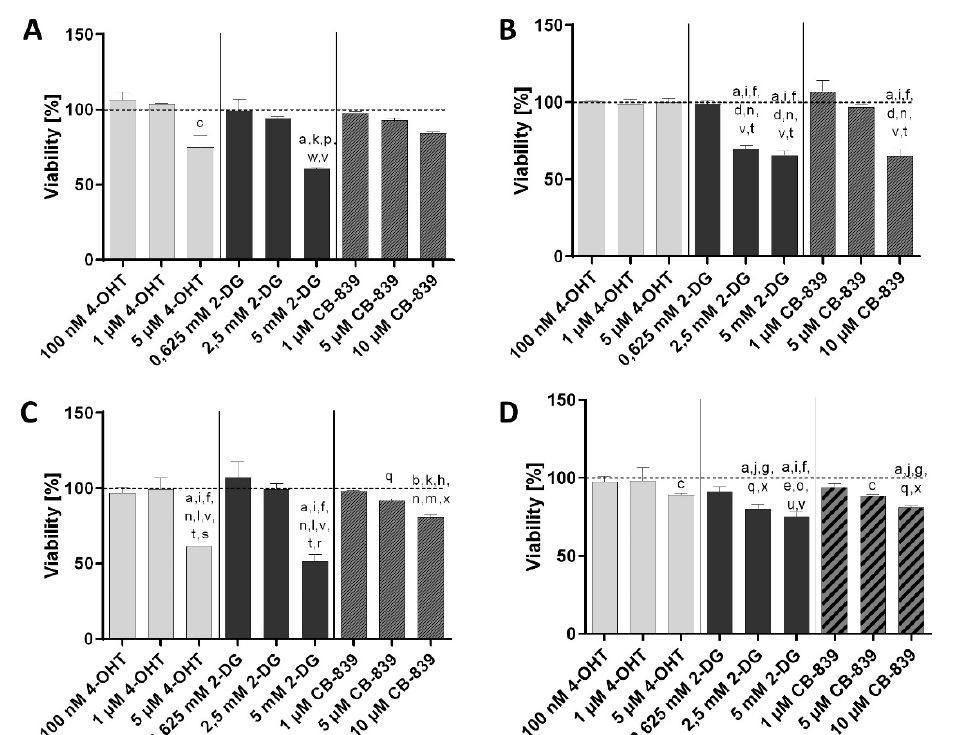
Figure 1. Viability of human breast cancer cell lines MCF7 ( A ), T47D ( C ) and their tamoxifen- resistant sublines MCF7-TR ( B ) and T47D-TR ( D ) after treatment with or without 4-hydroxytamoxifen (4-OHT), inhibitor 2-Deoxy-D-Glucose (2-DG) or glutaminase inhibitor CB-839. Columns represent means ± SEM of data obtained from three independent experiments in three different passages of the cell lines. a, p < 0.0001 vs. control; b, p < 0.001 vs. control; c, p < 0.05 vs. control; d, p < 0.0001 vs. 5 μ M 4-OHT; e, p < 0.01 vs. 5 μ M 4-OHT; f, p < 0.0001 vs. 1 μ M 4-OHT; g, p